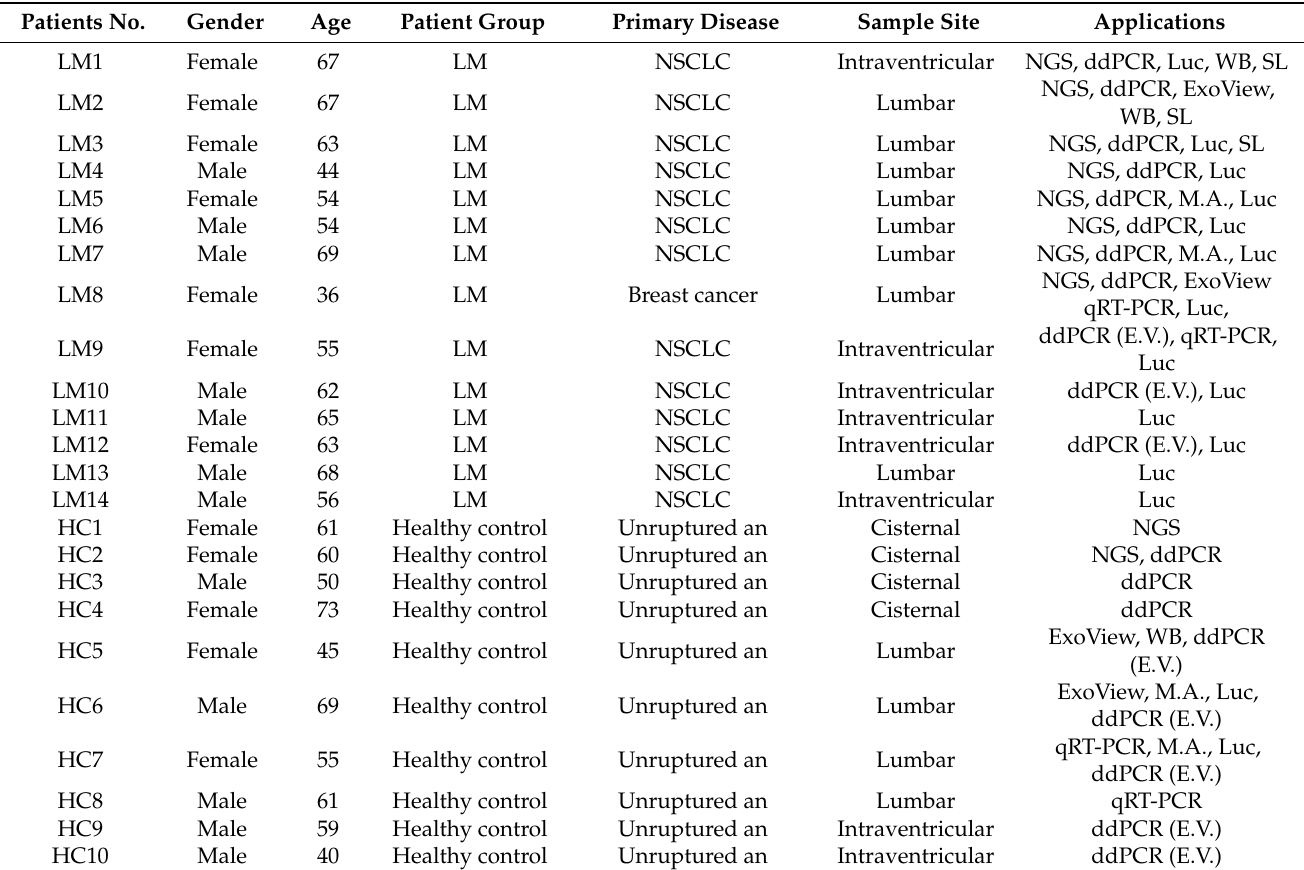
Table 1. Clinical characteristics of CSF samples and their applications in this study ( n = 24). Patients